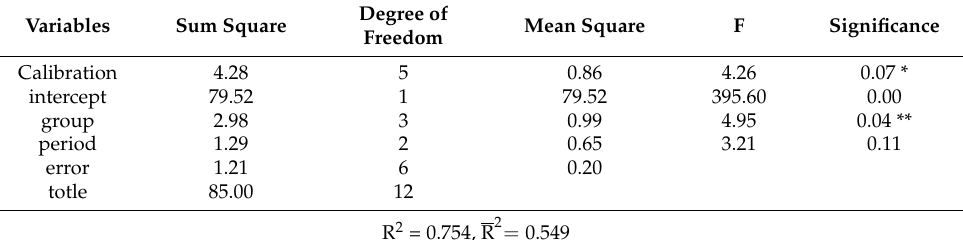
Table 6. Stability test.